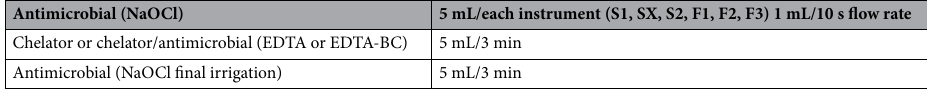
Table 5. The amount and velocity of the antimicrobials and chelators undertaken during the irrigation protocols.